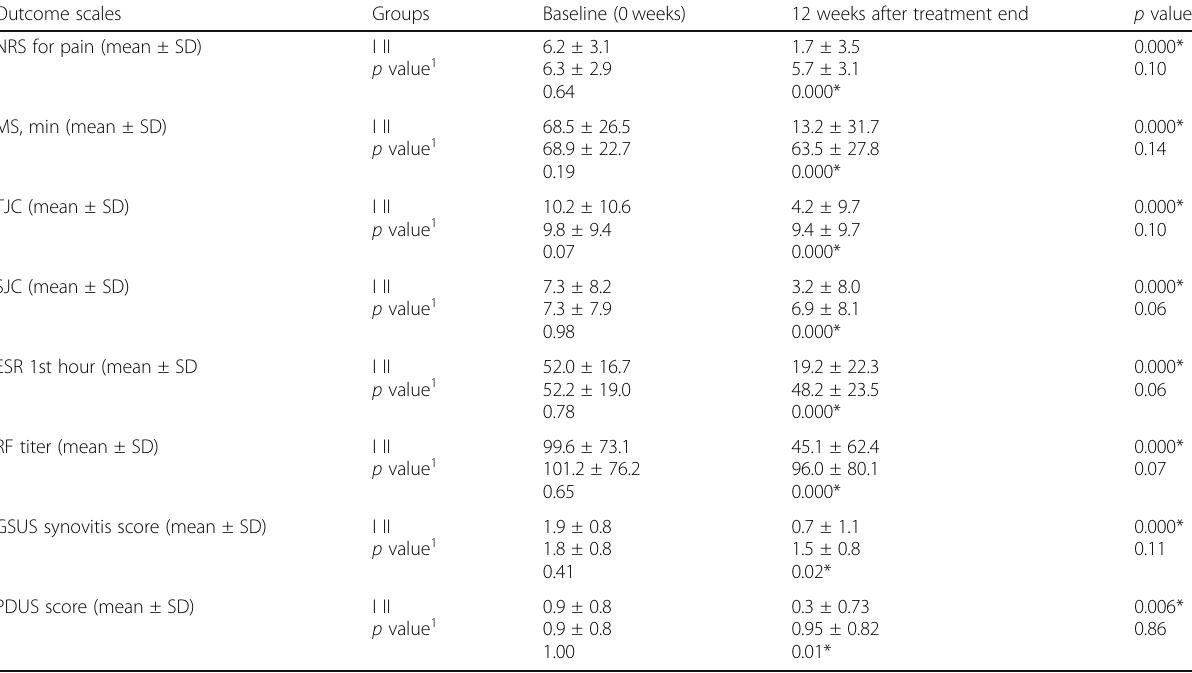
Table 3 Outcome measures before and after treatment in the study groups Outcome scales Groups